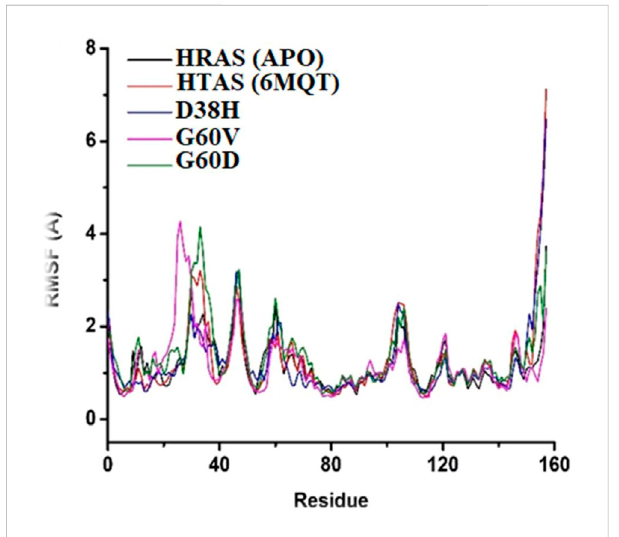
FIGURE 8 Conformational changes in structure that occurred in the docked protein complex at different time intervals.